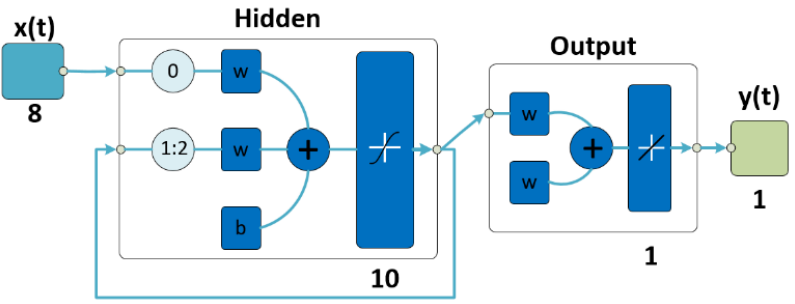
11 of 16 Figure 8. Fuel cell output voltage as a function of time.